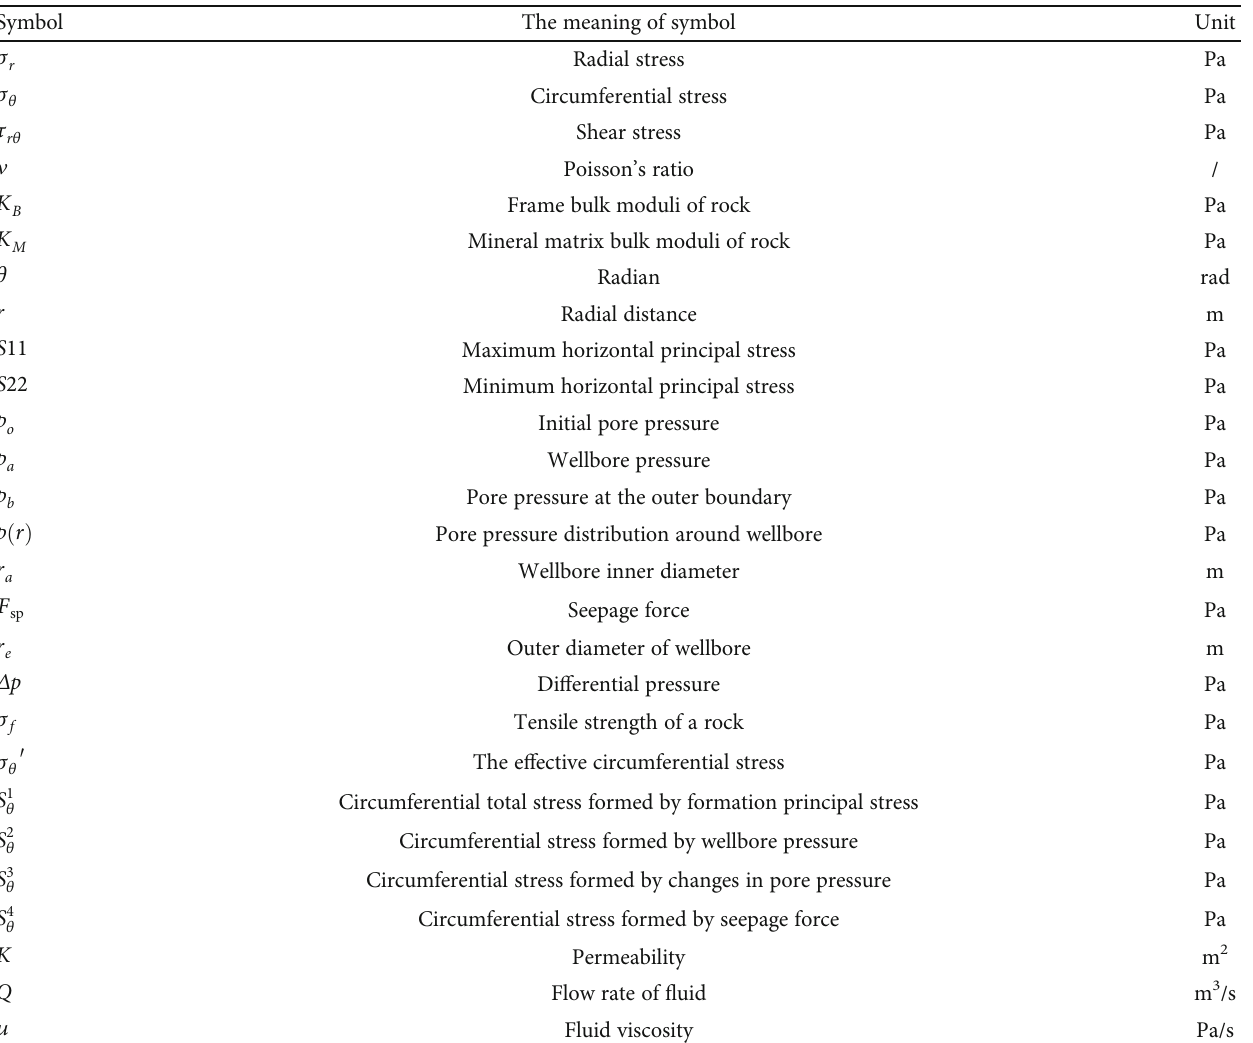
Figure 1: The cross-sectional graph of a vertical Table 1: Common symbols and units.